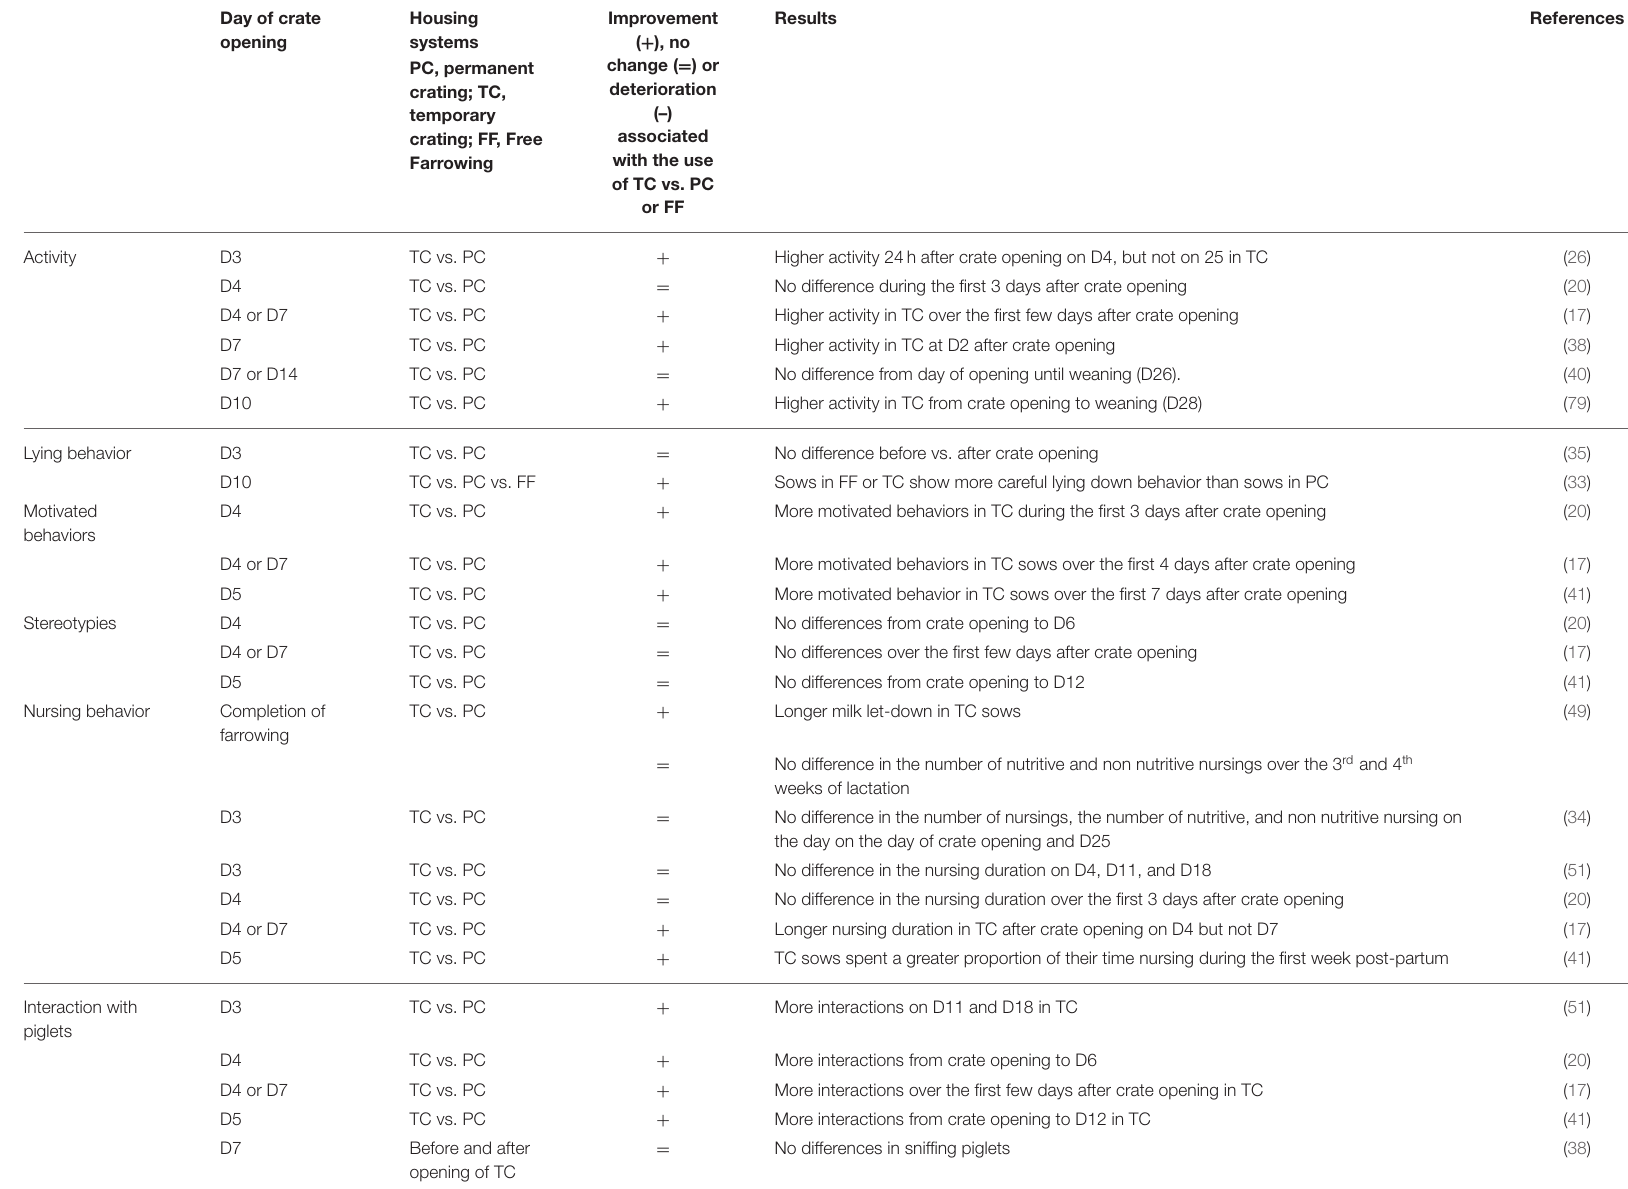
TABLE 3 | Effect of crate opening on sow